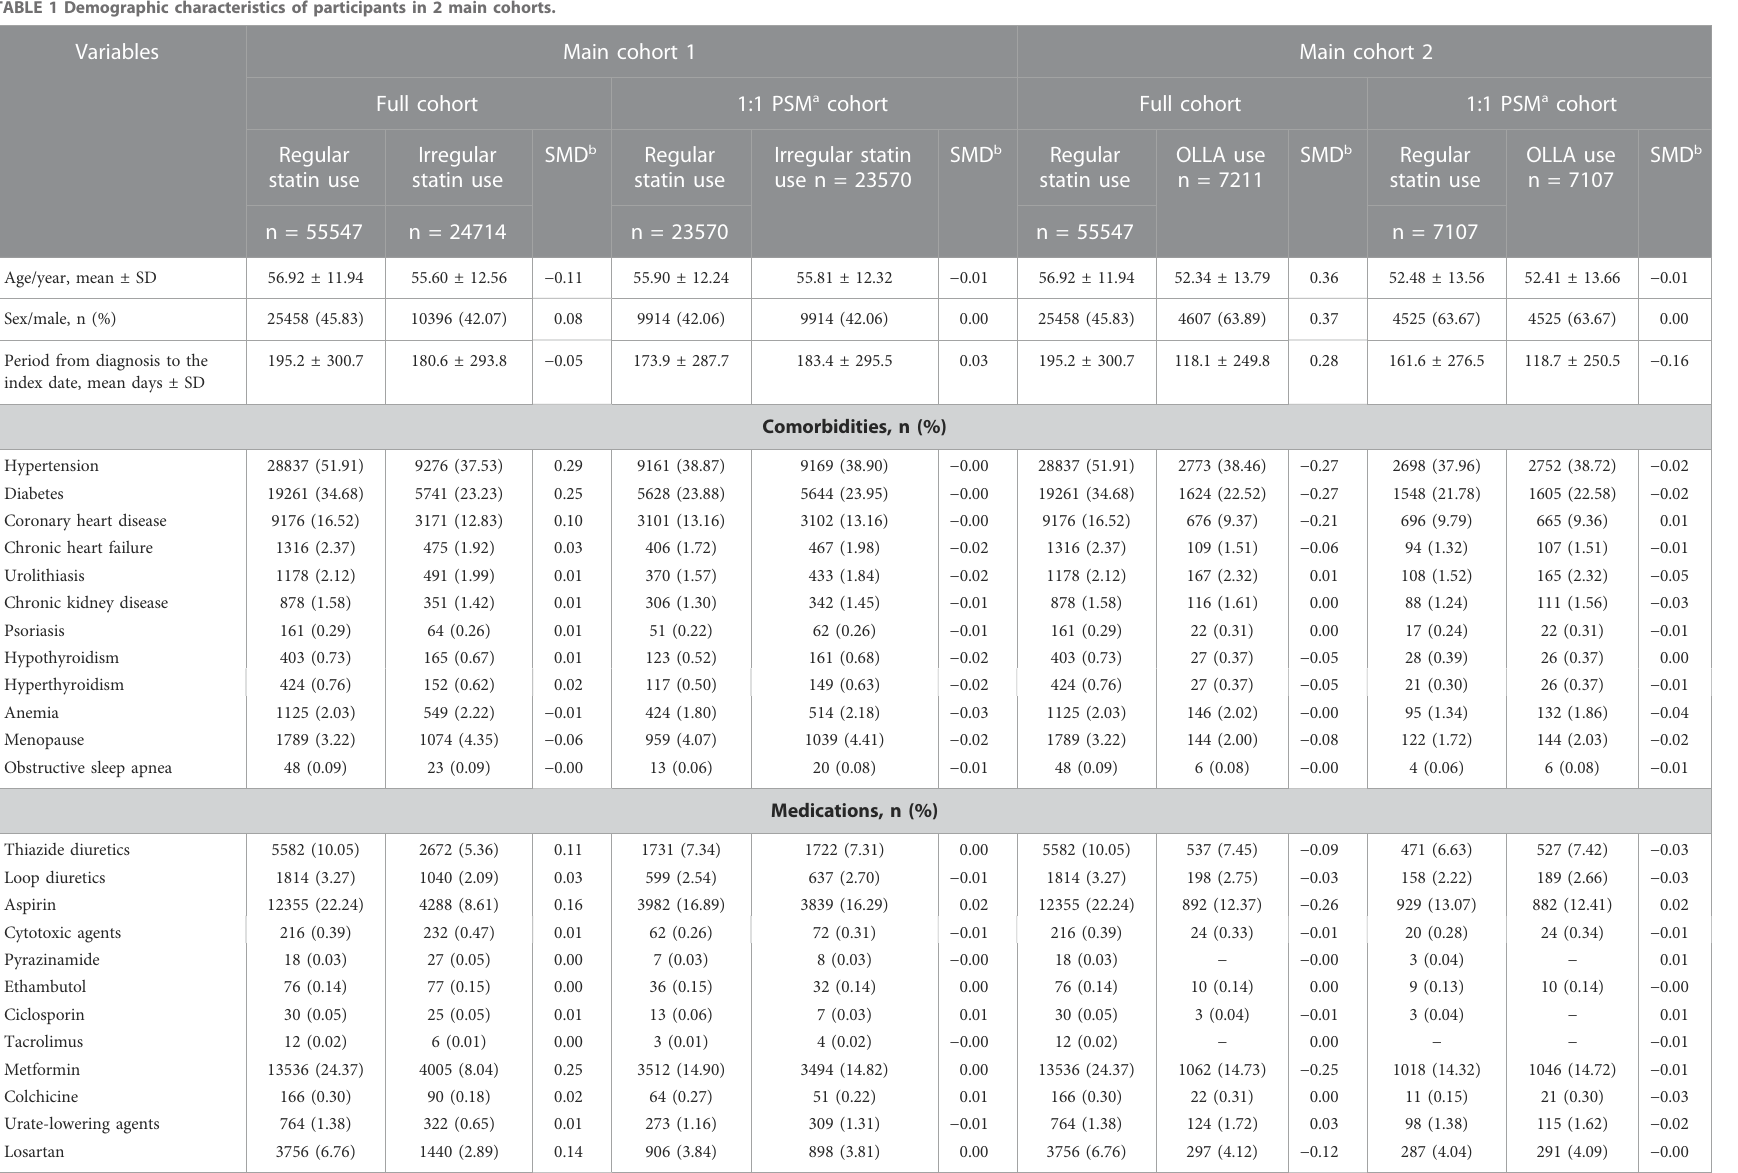
TABLE 1 Demographic characteristics of participants in 2 main